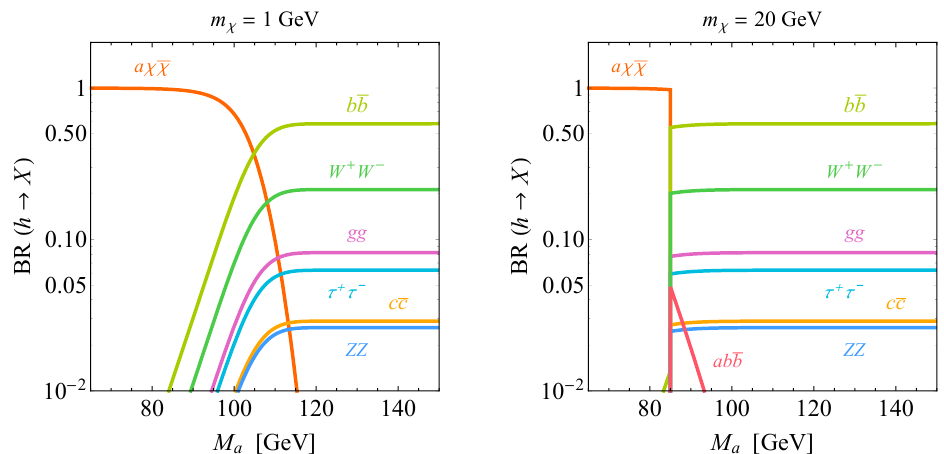
Figure 3 . Branching ratios of the lighter scalar h as a function of the pseudoscalar mass M a for two di(cid:11)erent choices of m (cid:31) as indicated in the headline of the plots. The other relevant parameters have been set to tan (cid:12) = 1, M H = M A = M H (cid:6) = 750 GeV, sin (cid:18) = 1 = and y (cid:31) =